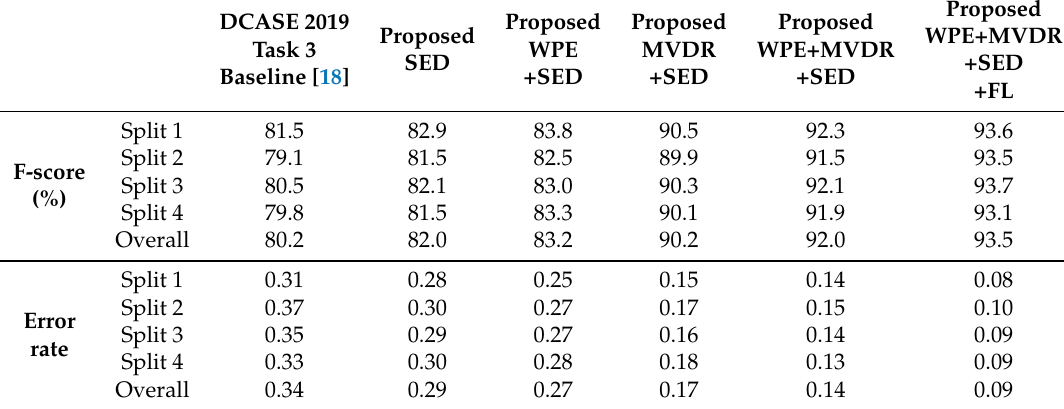
Table 4. F-score and ER results on the TAU Spatial Sound Events 2019-Microphone Array development dataset.